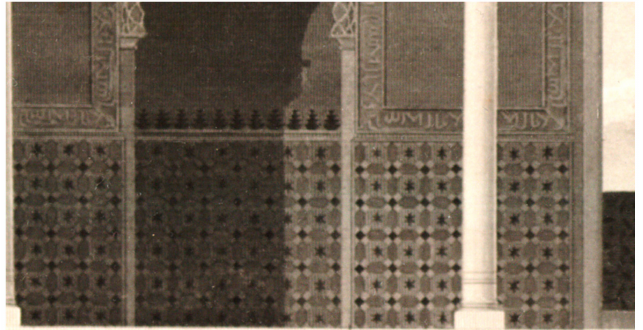
Figure 14. Elevation showing the portico and the Cuarto Dorado (Plate XXVIII). Drawing by James Cavanah Murphy (1813). © Archivo del Patronato de la Alhambra y Generalife, Fondo Romanones, A-5-3-13.